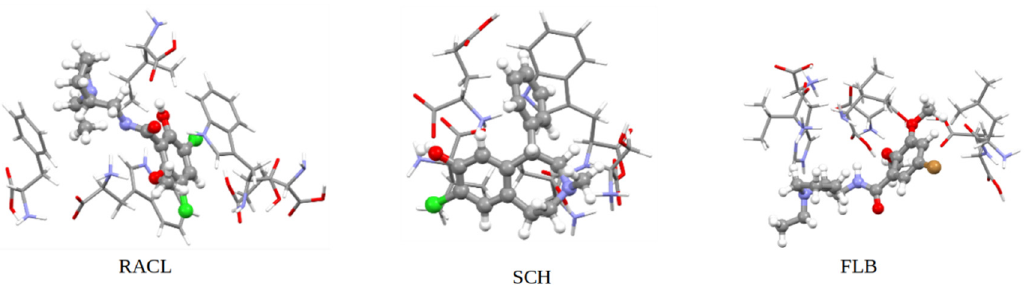
Figure 10. Optimized geometries of the investigated complexes at D2DR’s top docked position at the ONIOM ( ω B97XD/6–311+G (d,p): ω B97XD/3–21G) level of theory.